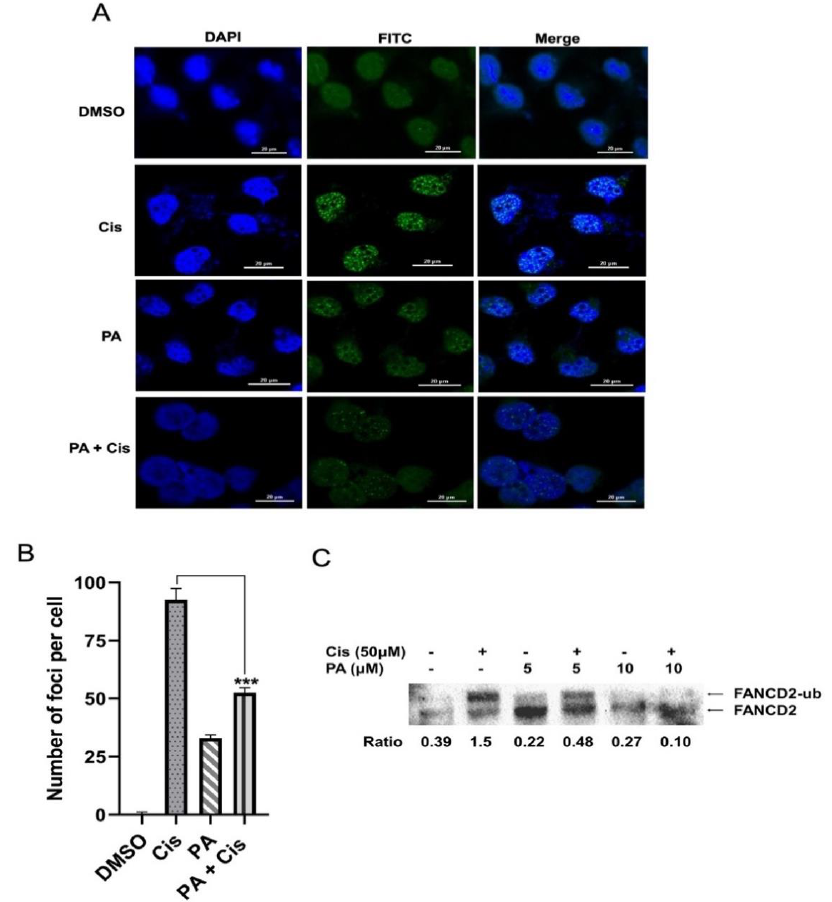
Figure 6. Planispine A inhibits the FA/BRCA pathway. ( A ) Immunofluorescence for FANCD2 foci; percentage of cells with more than 5 foci were determined in at least 150 cells (60X). Scale bar, 20 µ m. ( B ) Graphical representation FANCD2 foci, n = 3, *** p < 0.001 vs. cisplatin. ( C )